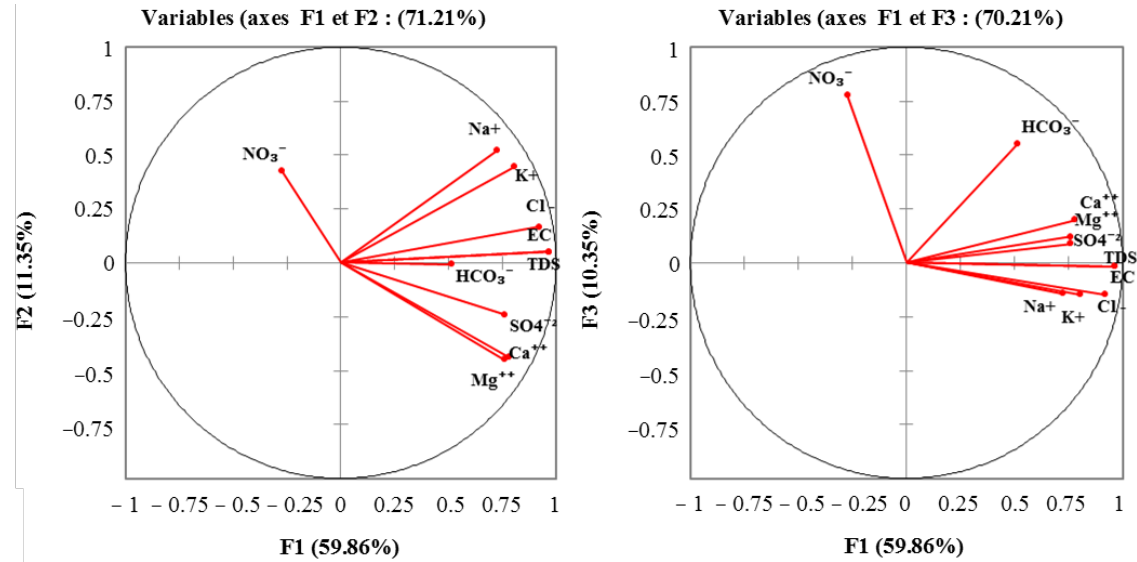
Figure 7. Plots of PCA scores for F2 vs. F1 ( a ) and F3 vs. F1 ( b ). Table 3. Correlation between the different physicochemical parameters and factors.